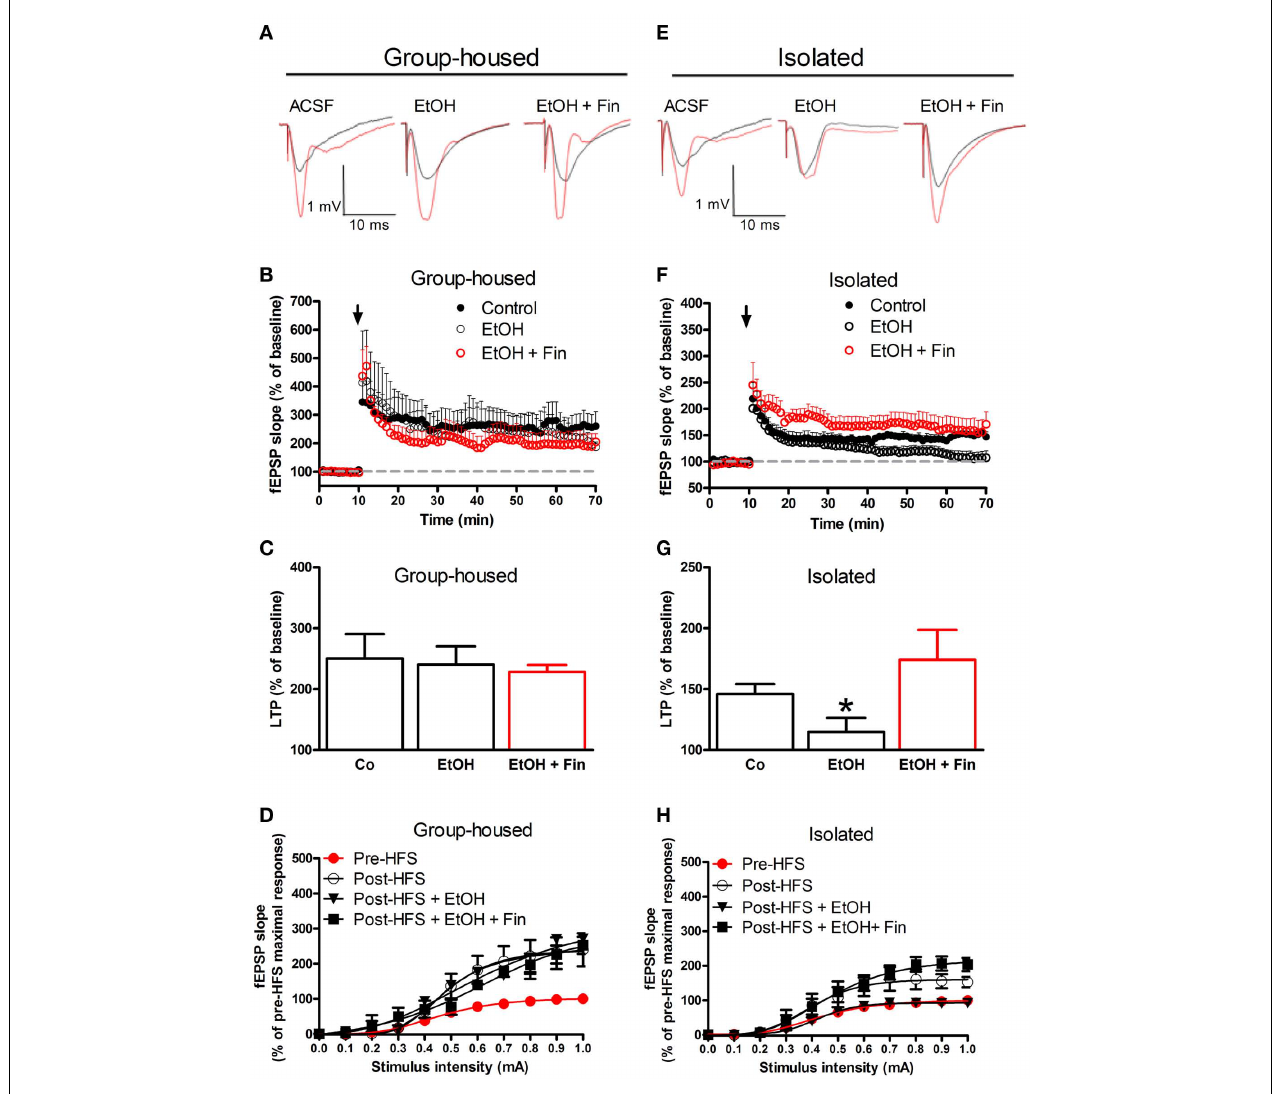
finasteride, as indicated. Data represent fEPSP slope at the indicated times expressed as a percentage of that at baseline and are means ± SEM ( n = 5 or 6 slices). (C,G) The extent of LTP was calculated by averaging the change in fEPSP slope apparent between 50 and 60min after HFS in hippocampal slices from GH (C) and SI (G) mice. Data are means ± SEM ( n = 5 or 6 slices). * p < 0.05 vs. control. (D,H) I–O relations determined before and 60min after HFS in GH (D) and SI (H) mice. Data are expressed as a percentage of the maximal response measured before HFS and are means ± SEM ( n = 8–12